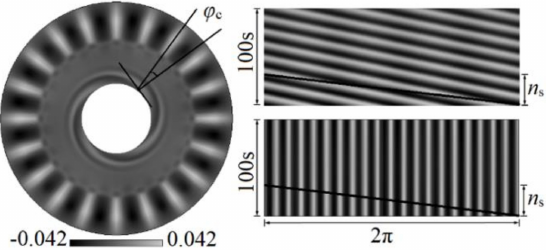
Figure 10. Snapshot of concentration fluctuations ( left ) and STD ( right ) at Re s = –1123, Re T =